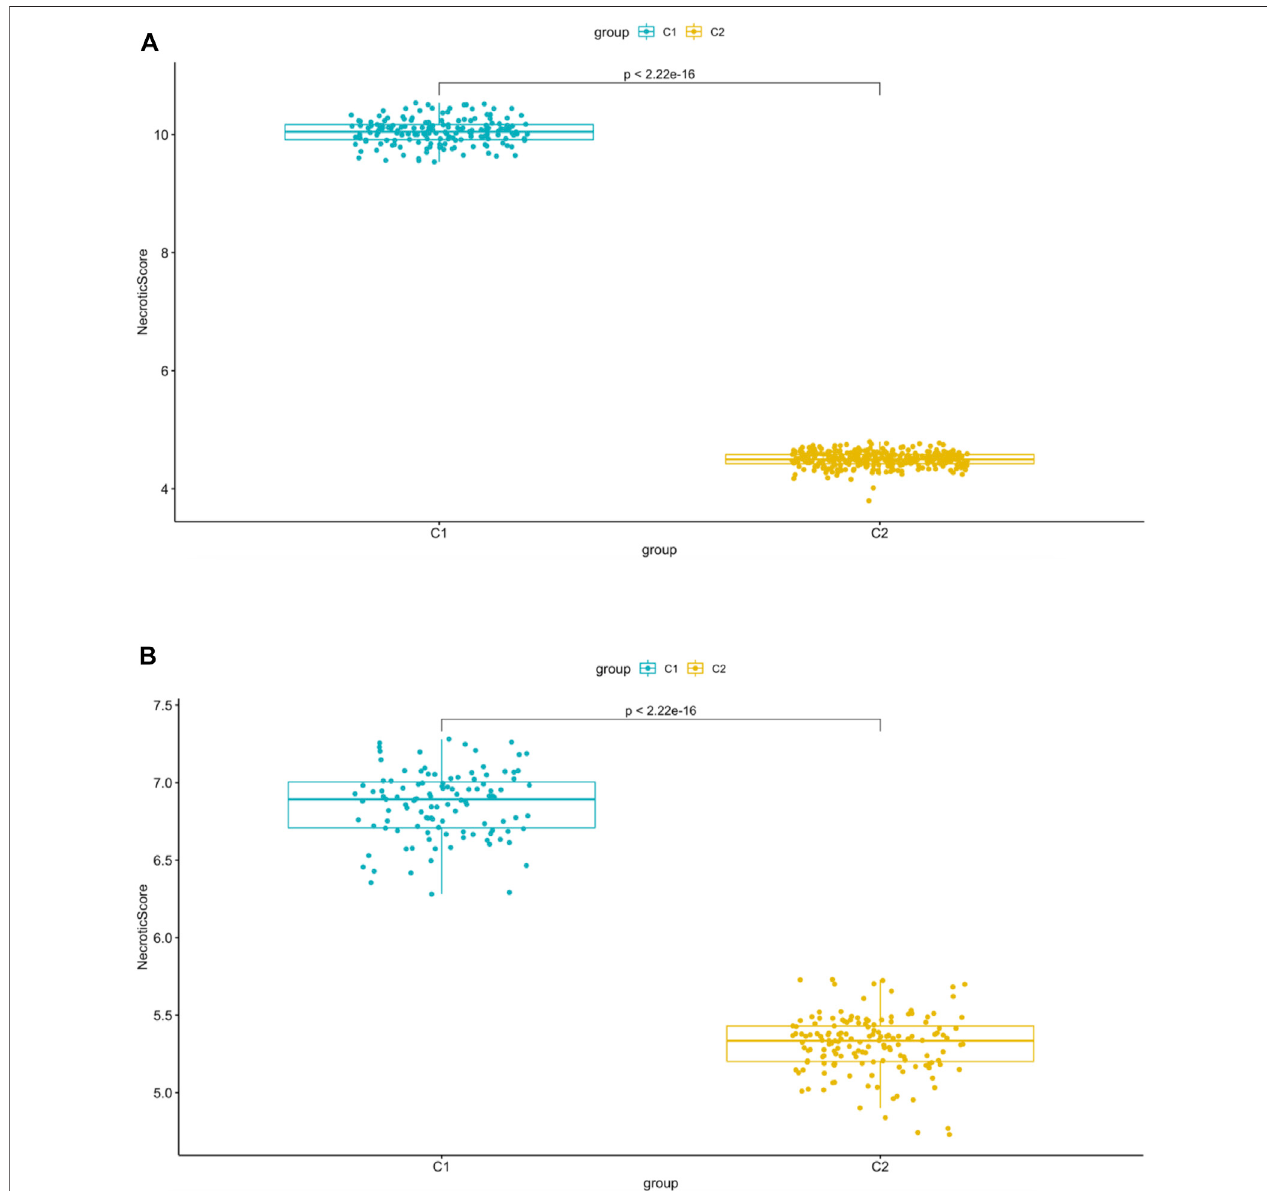
FIGURE 3 | NecroticScore is a predictive factor for survival and strati fi es the immunophenotype and HPV status. (A – B) NecroticScore in TCGA and GSE65858 dataset. (C) The Kaplan-Meier plot displays signi fi cant differences of survival rate among the high-NecroticScore and low-NecroticScore in the TCGA database, high (140cases), low (244cases), Unit of Time (years). (D) The Kaplan-Meier plot displays signi fi cant differences of survival rate among the high-NecroticScore and low- NecroticScore in the GSE65858 database, high (114cases), low (153cases) Unit of Time (years). (E) NecroticScore in TCGA dataset among the group of HPV